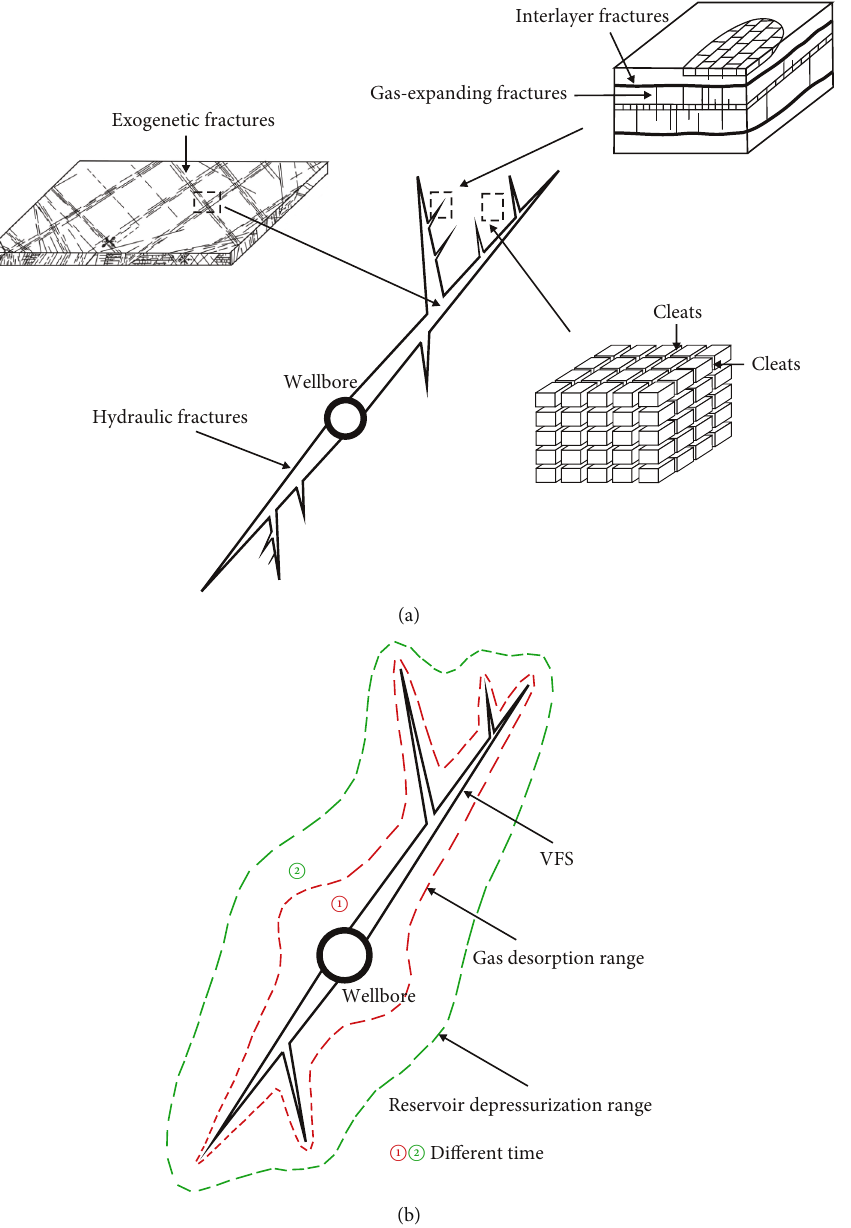
Figure 4: Transmission of reservoir pressure and gas desorption range (revised from [43]): (a) reservoir pressure transmission in VFS; (b) variations of reservoir depressurization and gas desorption range in the horizontal